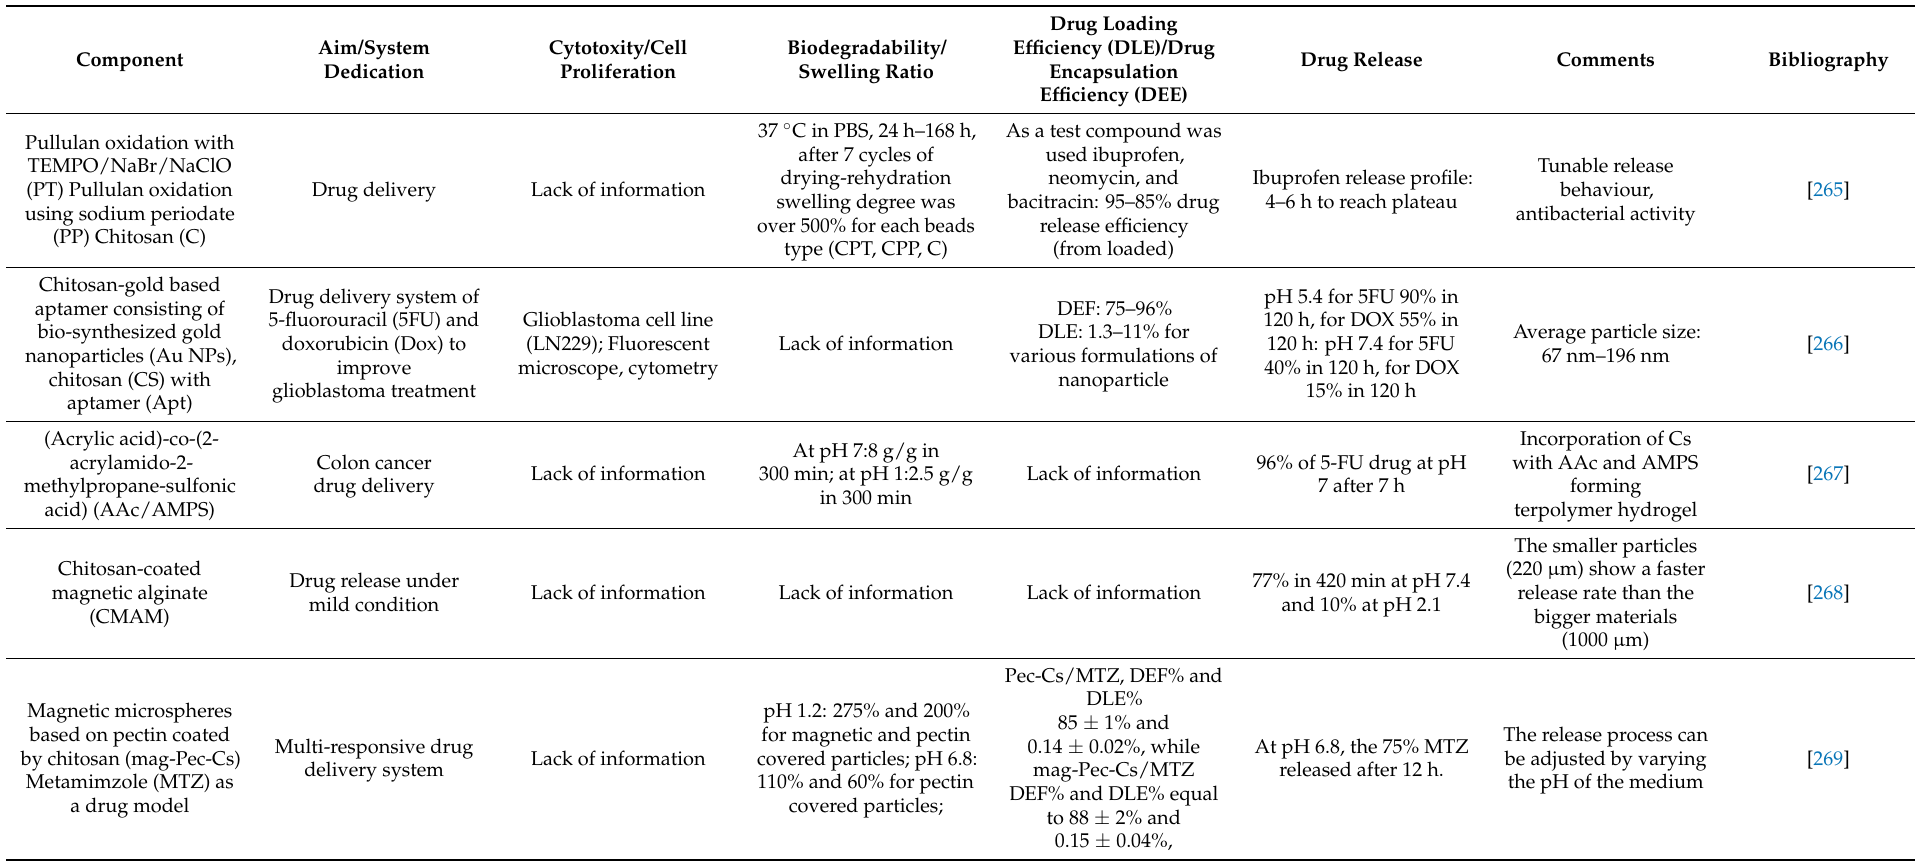
Table 1. Drug delivery systems based on